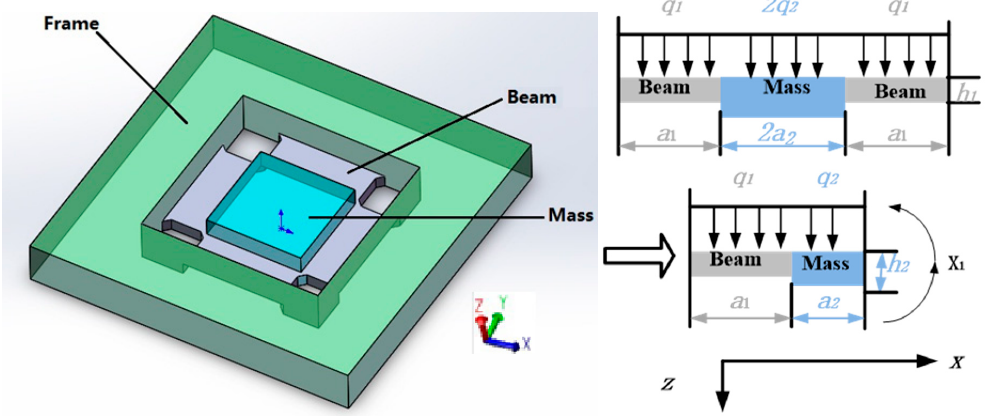
Figure 1. HGMA structure schematic and size.